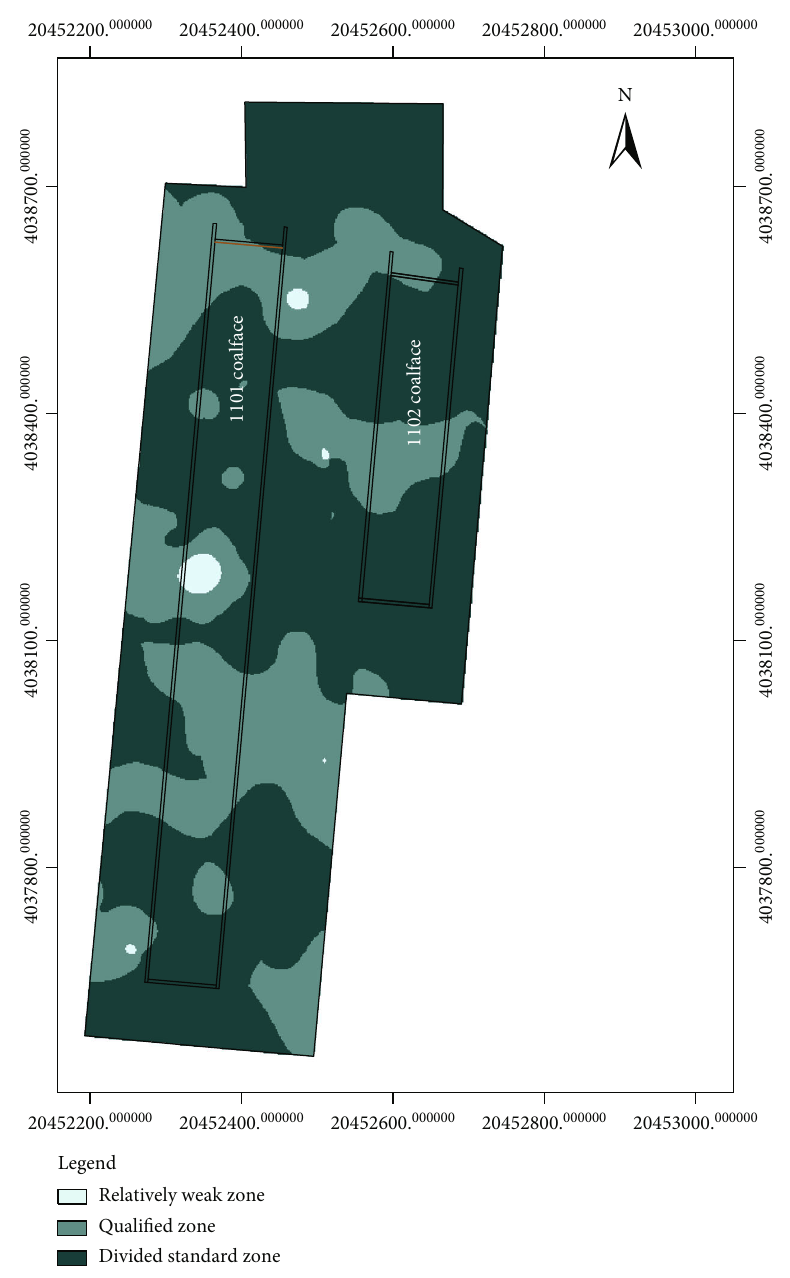
Figure 7: Evaluation of the directional drilling and grouting in Xujiazhuang limestone